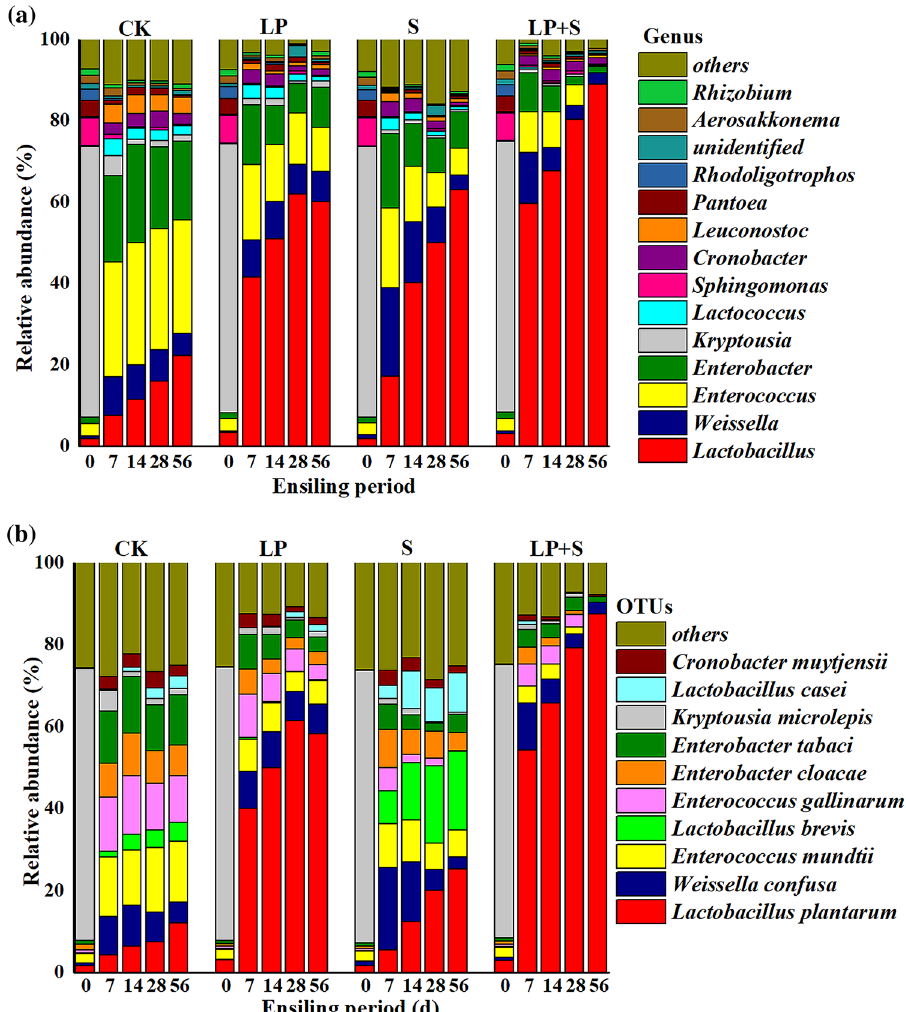
Figure 2. Relative abundance of the bacterial community at the genus ( a ) and species levels ( b ). CK, control; LP, Lactobacillus plantarum ; S, sucrose; LP + S, the addition of both sucrose and Lactobacillus plantarum